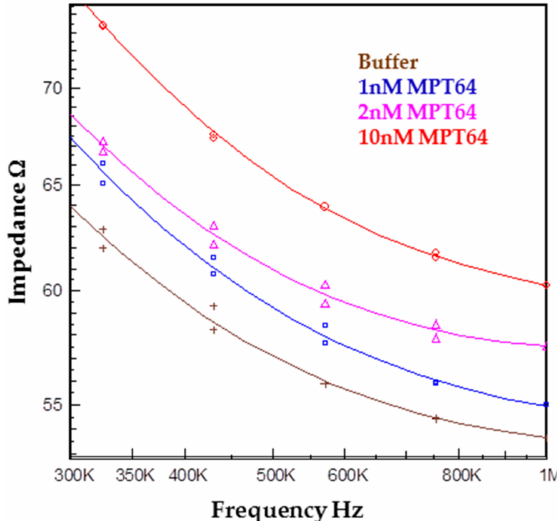
Figure 14. Impedance magnitude data for the detection of the target MPT64 at different concentrations of 1, 2, and 10 nM. The impedance magnitude increased with an increase in the target concentration.